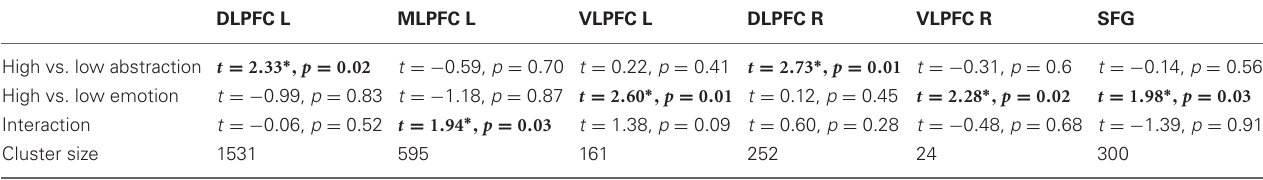
Table 3 | Functional ROI analysis.